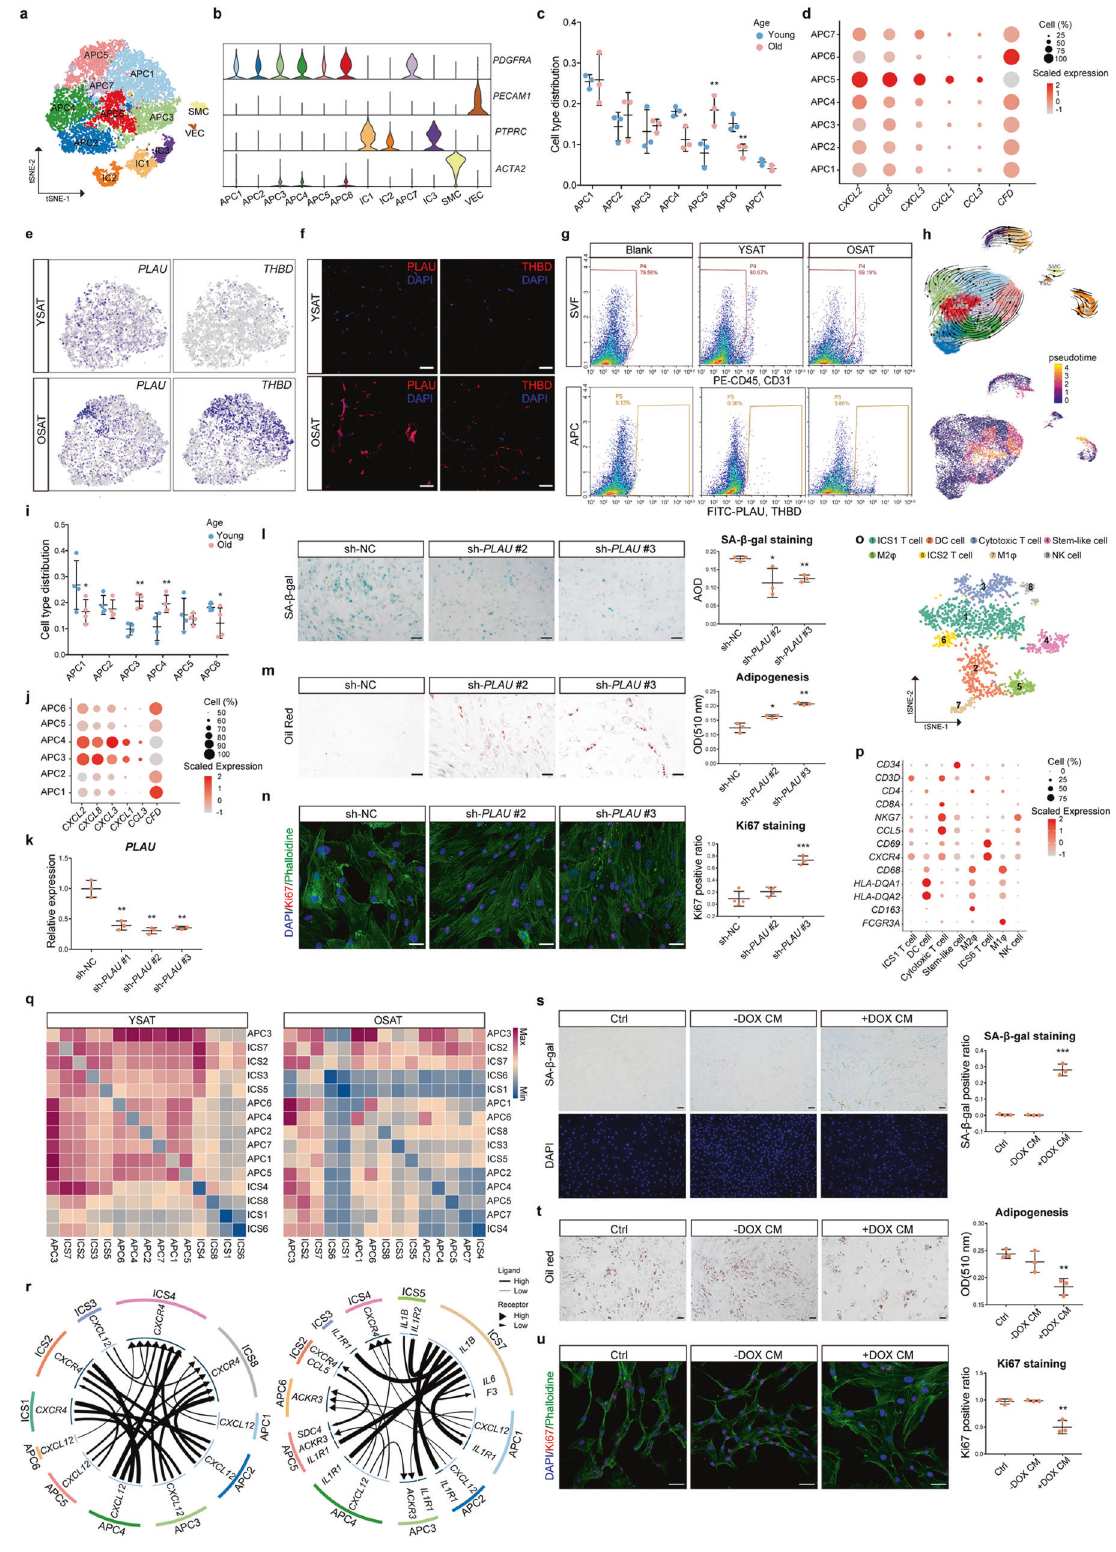
(supplementary Fig. S6a, b). Conditioned medium of senescent macrophages signi fi cantly increased PLAU expression level in young human primary APC (supplementary Fig. S6c), as well as elevated the expression level of CXCL2 , CXCL3 , CXCL8 , which are